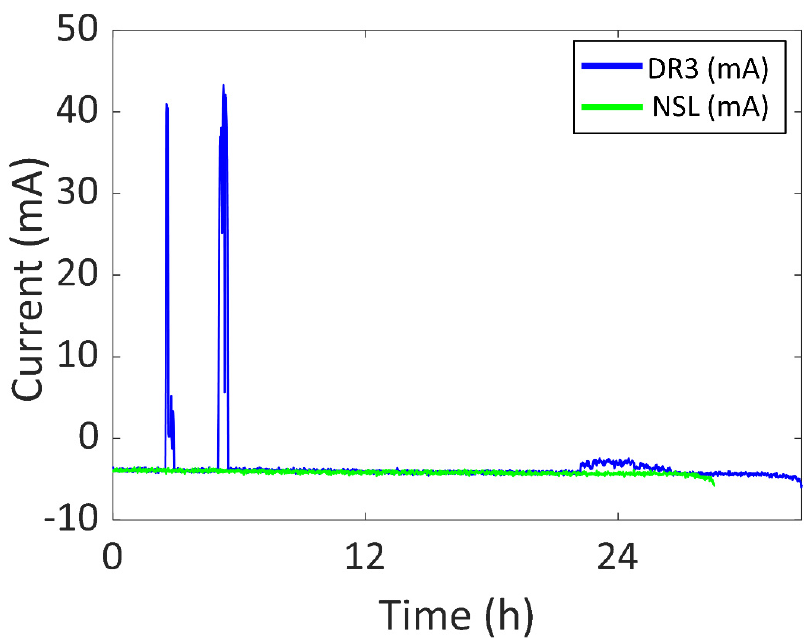
Figure 15. Battery current vs. time of DR3 and NSL experiments.